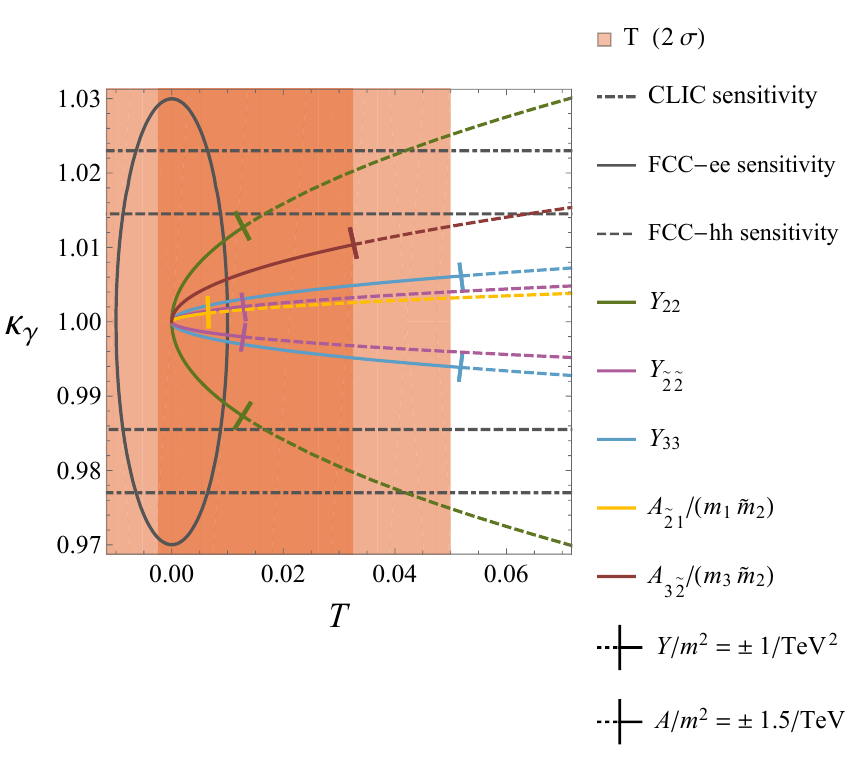
Figure 5. Correlations between κ γ and T for different Lagrangian parameters, assuming that only one of them is non-zero at a time and assuming all LQ masses to be